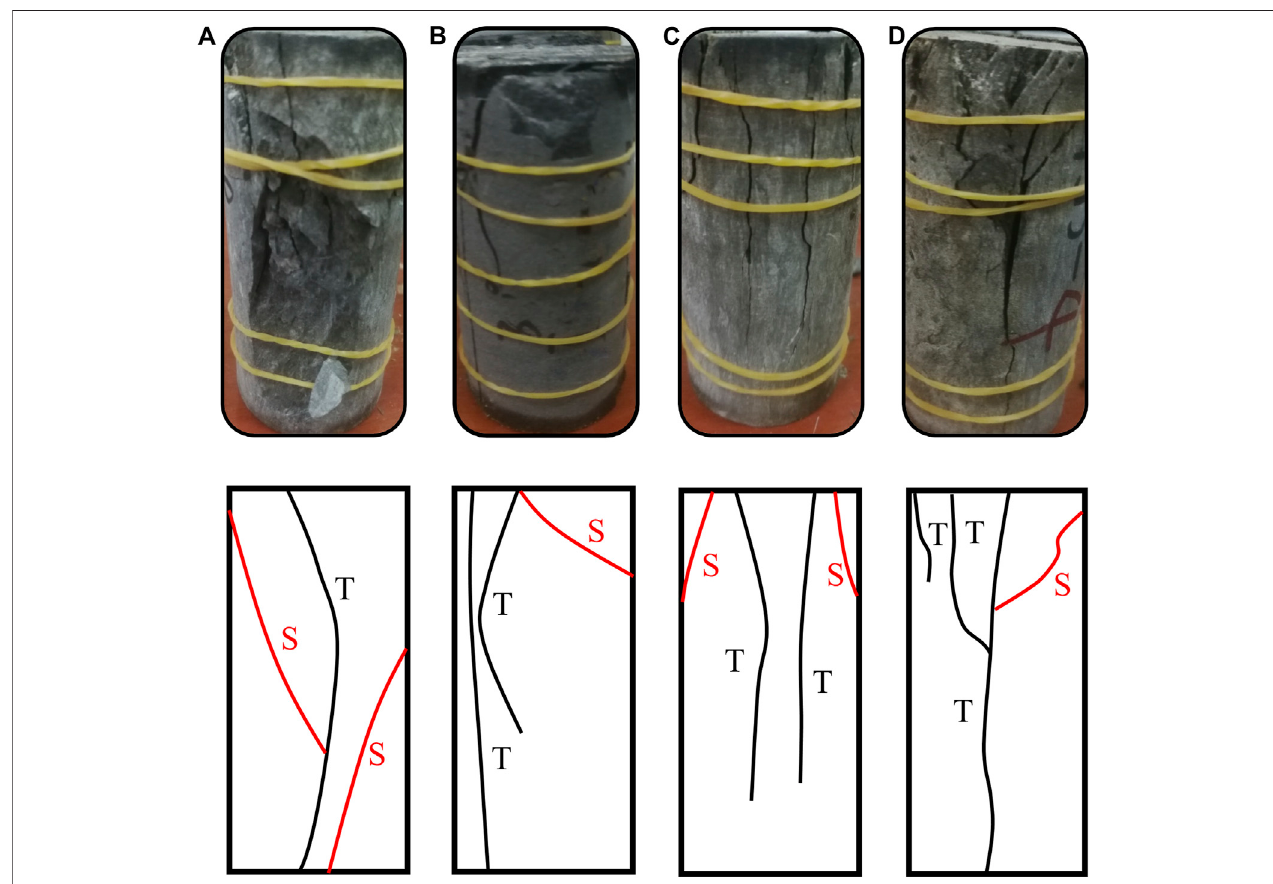
FIGURE 11 | Failure modes of rock samples under different high-humidity action time: (A) 0 d; (B) 30 d; (C) 60 d; (D) 90 d.